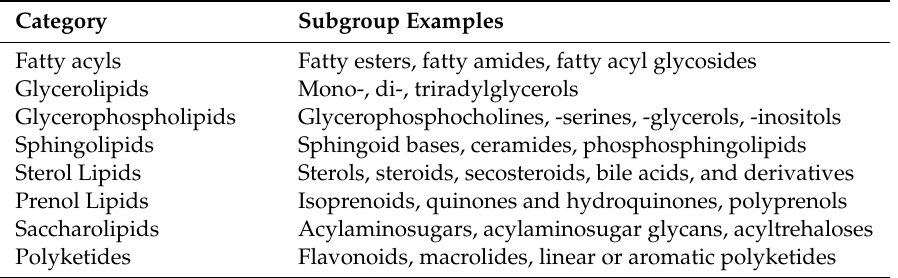
Table 1. Classification of lipids according LIPID MAPS with examples of subgroups